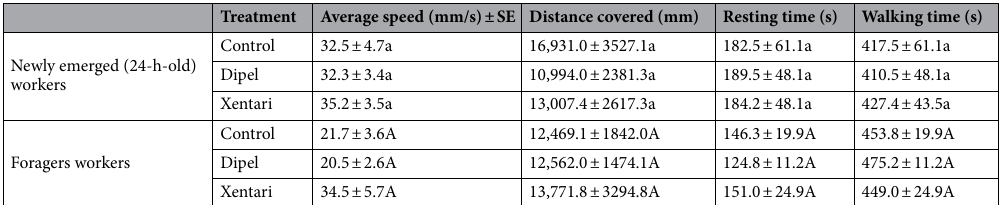
Table 1. Data showing the average speed of the honey bees (mm/s), distance covered (mm), walking time (s), and the resting time (s) of foragers and newly emerged (24-h-old) worker bees at 24 h after ingestion of Candi paste incorporated with the products [± standard error (SE)]. The same lowercase letters in the column indicate that there was no significant difference ( p < 0.05) for the foragers bees. The same uppercase letters in the column indicate that there was no significant difference ( p < 0.05) for the newly emerged (24-h-old) worker bees.